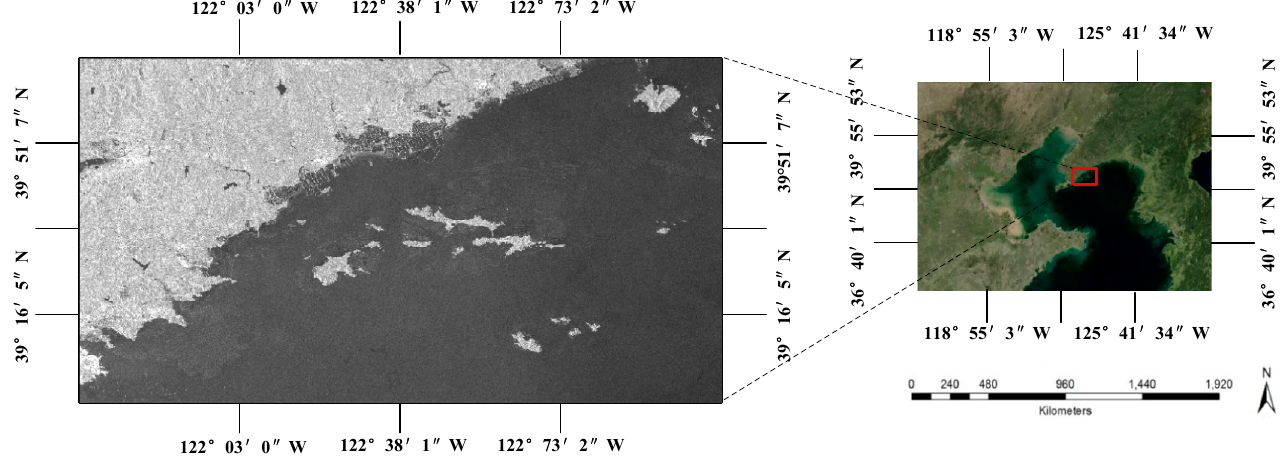
Figure 3. View of the study area.